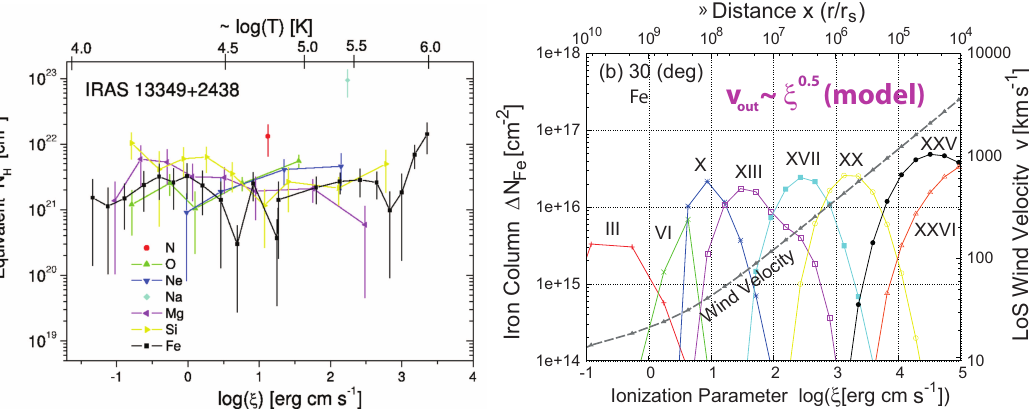
Figure 1. ( Left ) The AMD of IRAS 13349+2438 (from [21]) determined independently from the transitions of each element and ionization state shown. The weak dependence of N H on ξ is apparent. ( Right ) The ionization structure of Fe for a model with s = 1 and θ = 30deg. The ionization state of Fe decreases with increasing distance; however, the maximum N H of each ion remains roughly constant (from [17]). Also shown is the wind velocity with distance, indicating that lower ionization ions have lower